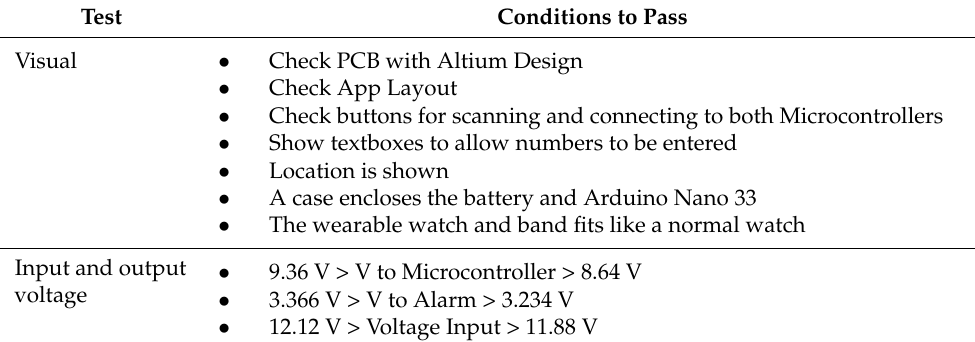
Figure 15. XYZ Filtered frequency data received from the wearable band. Table 1. Product Test and